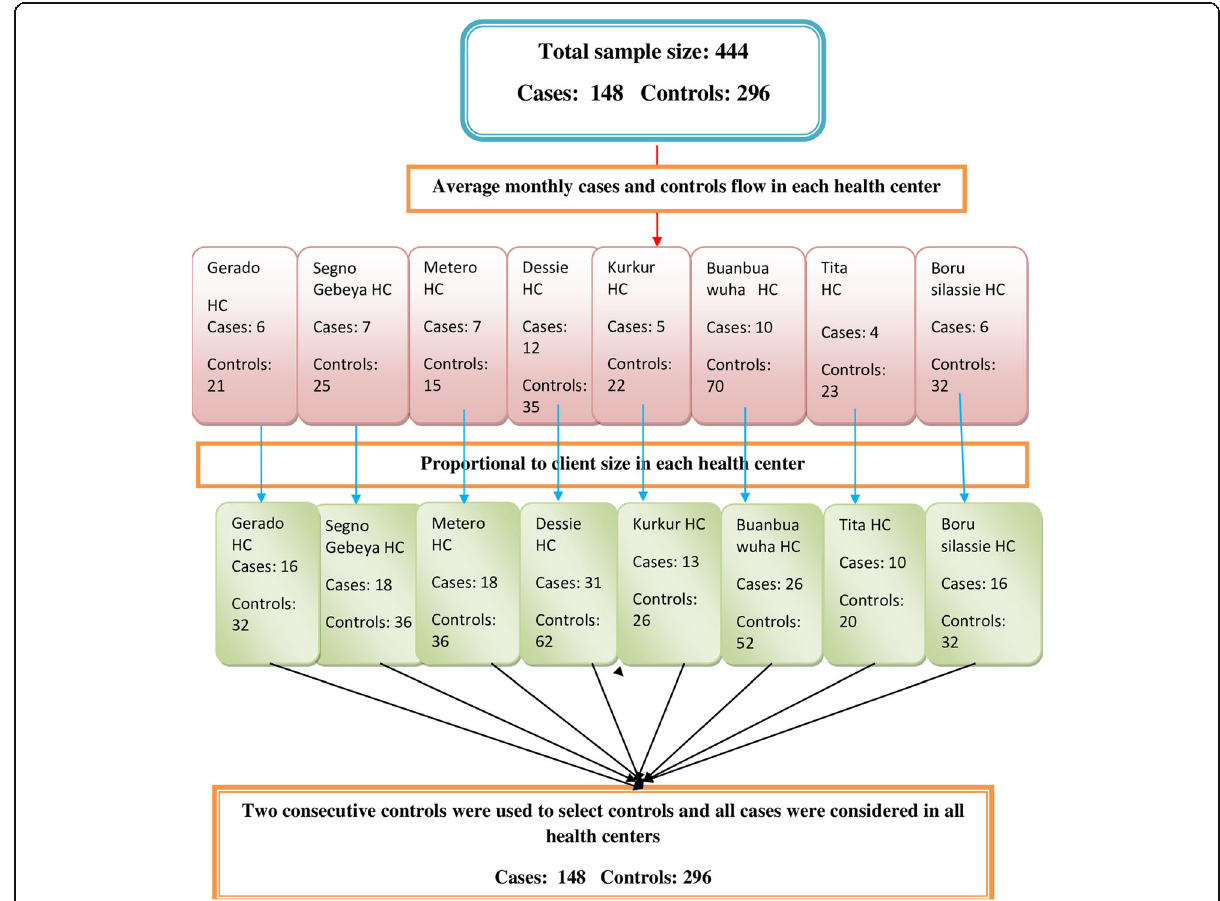
Fig. 1 Sampling procedures of children 2 – 59 months of age in Northeast Ethiopia,